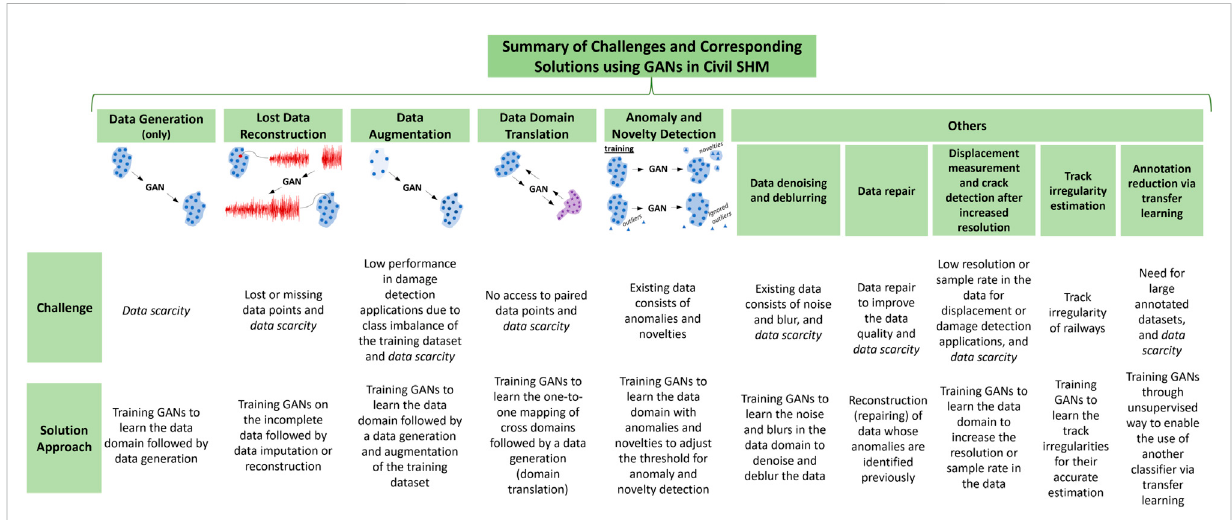
FIGURE 19 Summary of challenges and corresponding solution approaches using GANs in civil